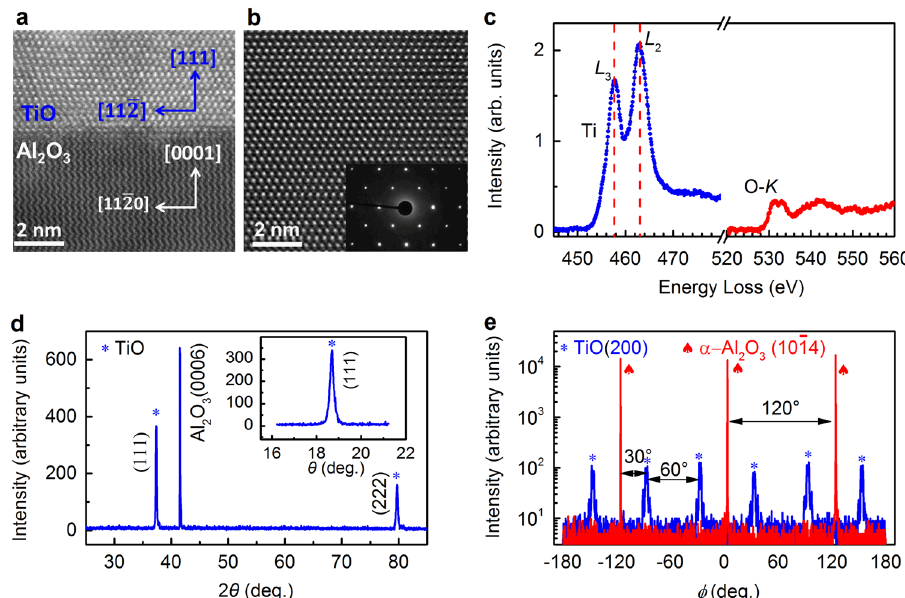
Fig. 1 Structural and chemical characterizations . a , b HAADF-STEM images of TiO/Al 2 O 3 , at the a interface region and b TiO region. c Ti- L 3,2 and O- K edges EELS spectra of the TiO fi lm. d θ /2 θ XRD pattern of the TiO/ α -Al 2 O 3 (0001) heterostructure. The inset shows the rocking curve for the TiO (111) re fl ection. e XRD ϕ scan performed on TiO (200) and sapphire (10 1 4)